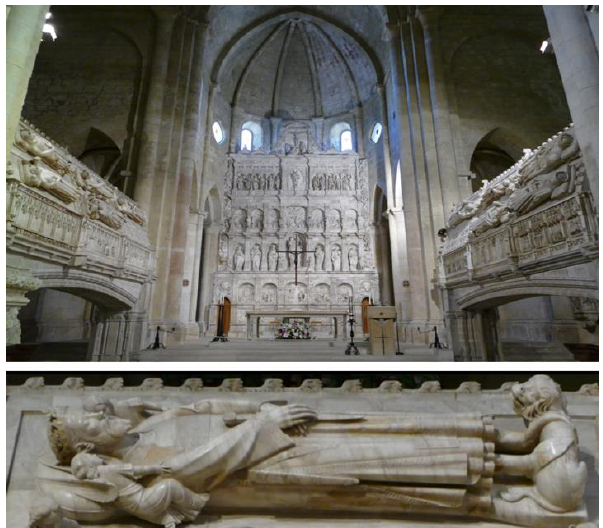
Figure 6. Capella Reial in Santa Maria de Poblet. Detail of the recumbent figure of Peter IV, restored by Marès. 1944-1949. © Monestir de Poblet. by Mar è s. 1944–1949. © Monestir de